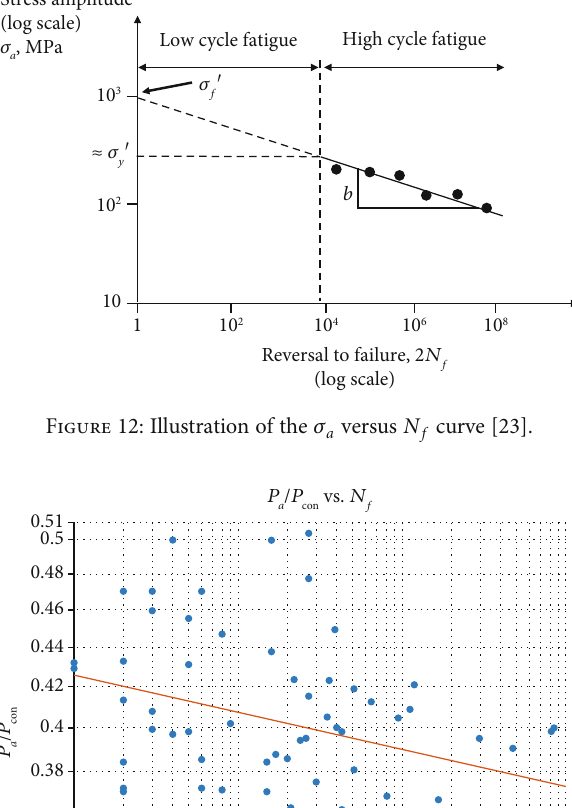
Figure 14: σ fi tted